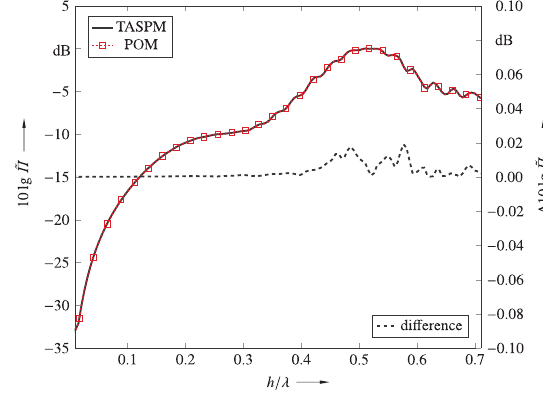
Figure 6: Comparison of dimensionless acoustic power output.